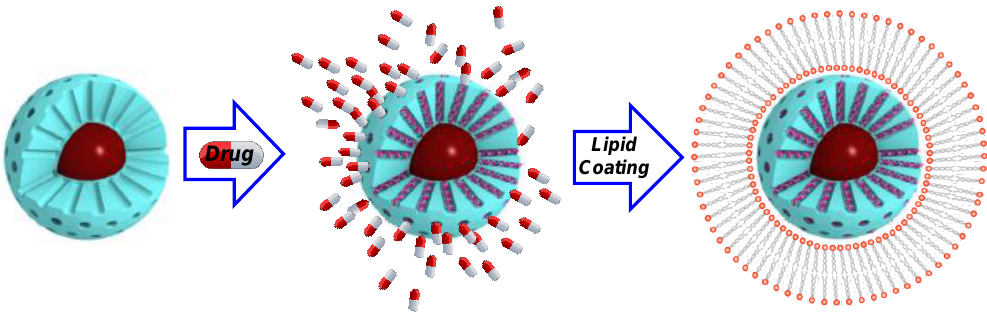
Figure 3. Multifunctional protocells arise from the coating of Mesoporous silica-based composites with lipid bilayers.